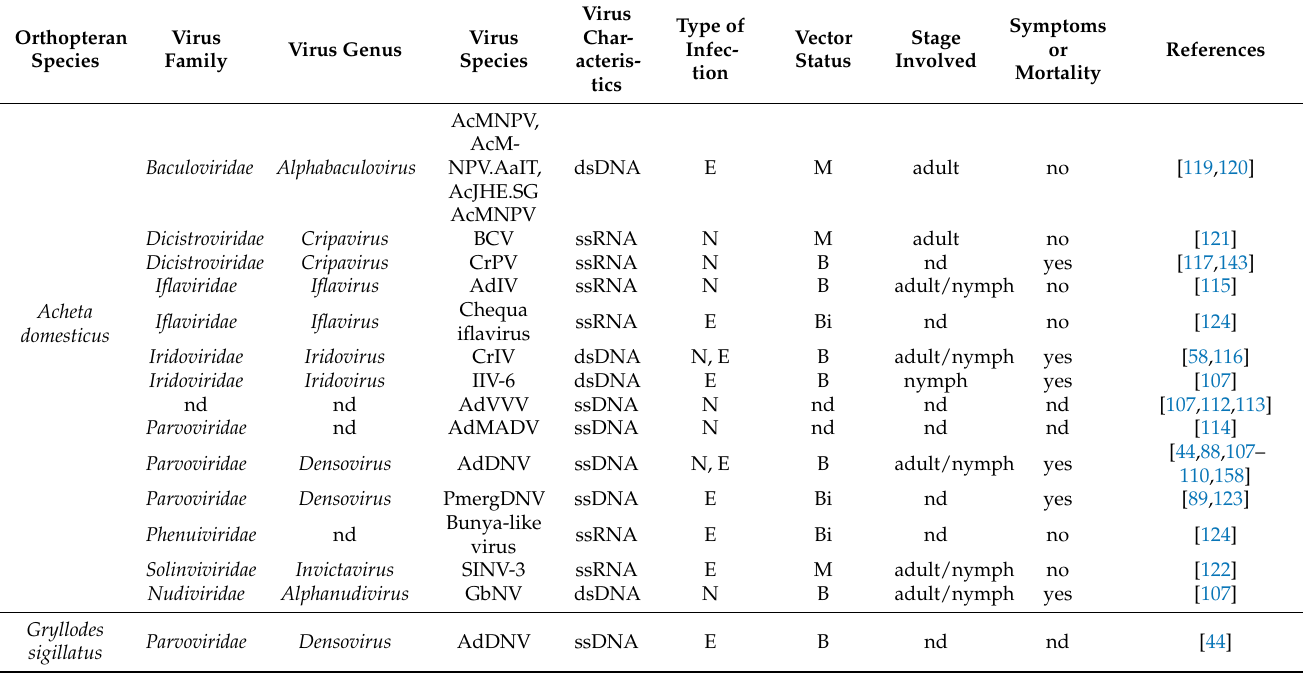
Table 3. Viruses detected in orthopteran edible